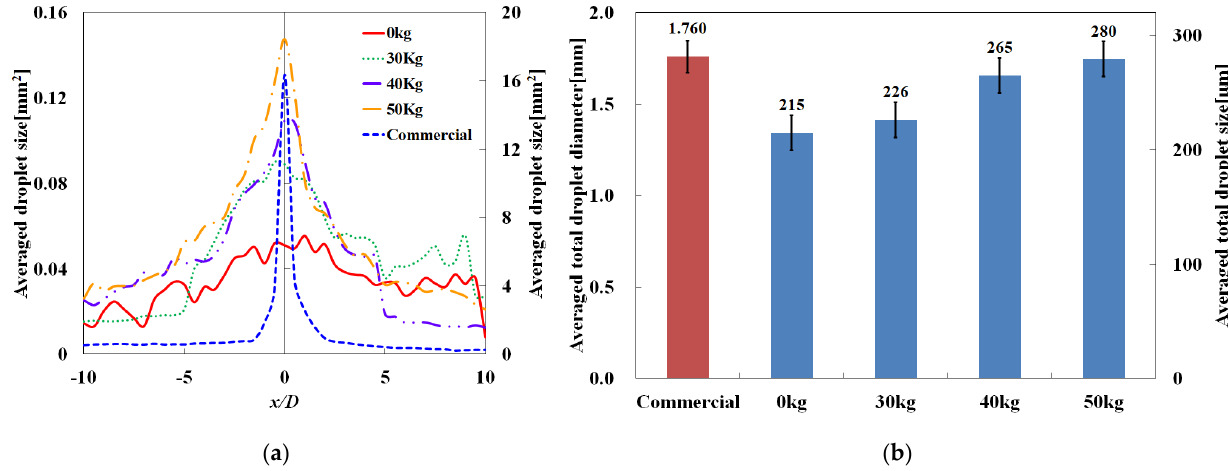
Figure 11. ( a ) Distributions of averaged particle size along a radial direction for the original nozzle and the feedback channel nozzle with various load. ( b ) Comparison of the total droplet diameter. The left and right axes are for the developed and commercial nozzles, respectively.